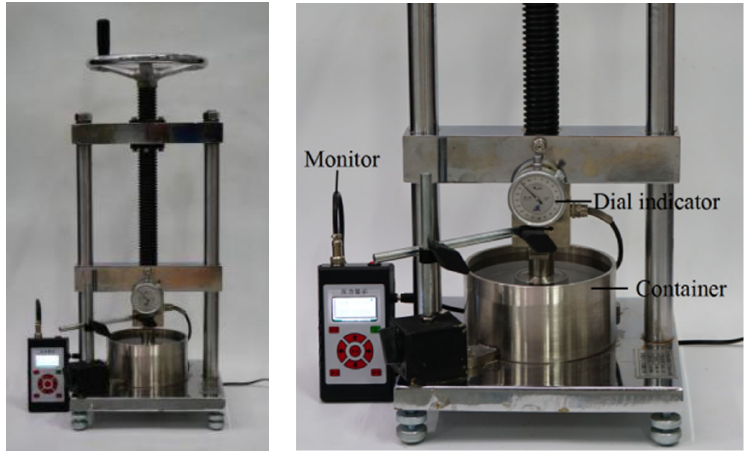
Figure 6. YYP ‐ 40 rock ‐ swelling pressure setup. Figure 6. YYP-40 rock-swelling pressure